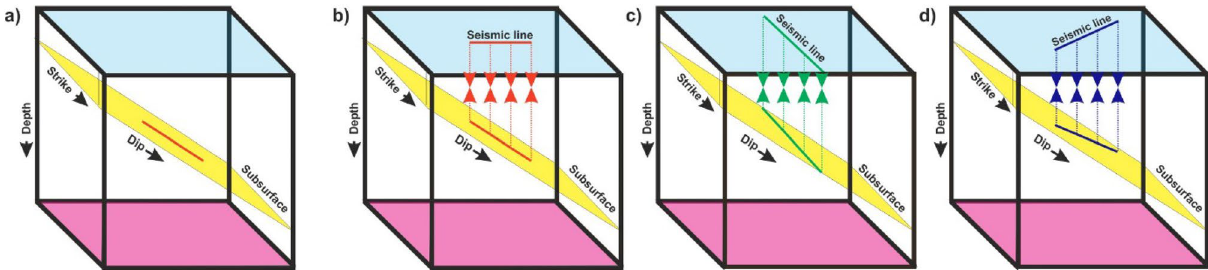
Figure 7. Schematic diagram showing the subsurface structure of a reflector with respect to profile direction. ( a ) Actual structure of the subsurface reflector Structure observed on a profile traversing: ( b ) across the strike- direction ( c ) along strike-direction, ( d ) some arbitrary angle to the strike of the profile.